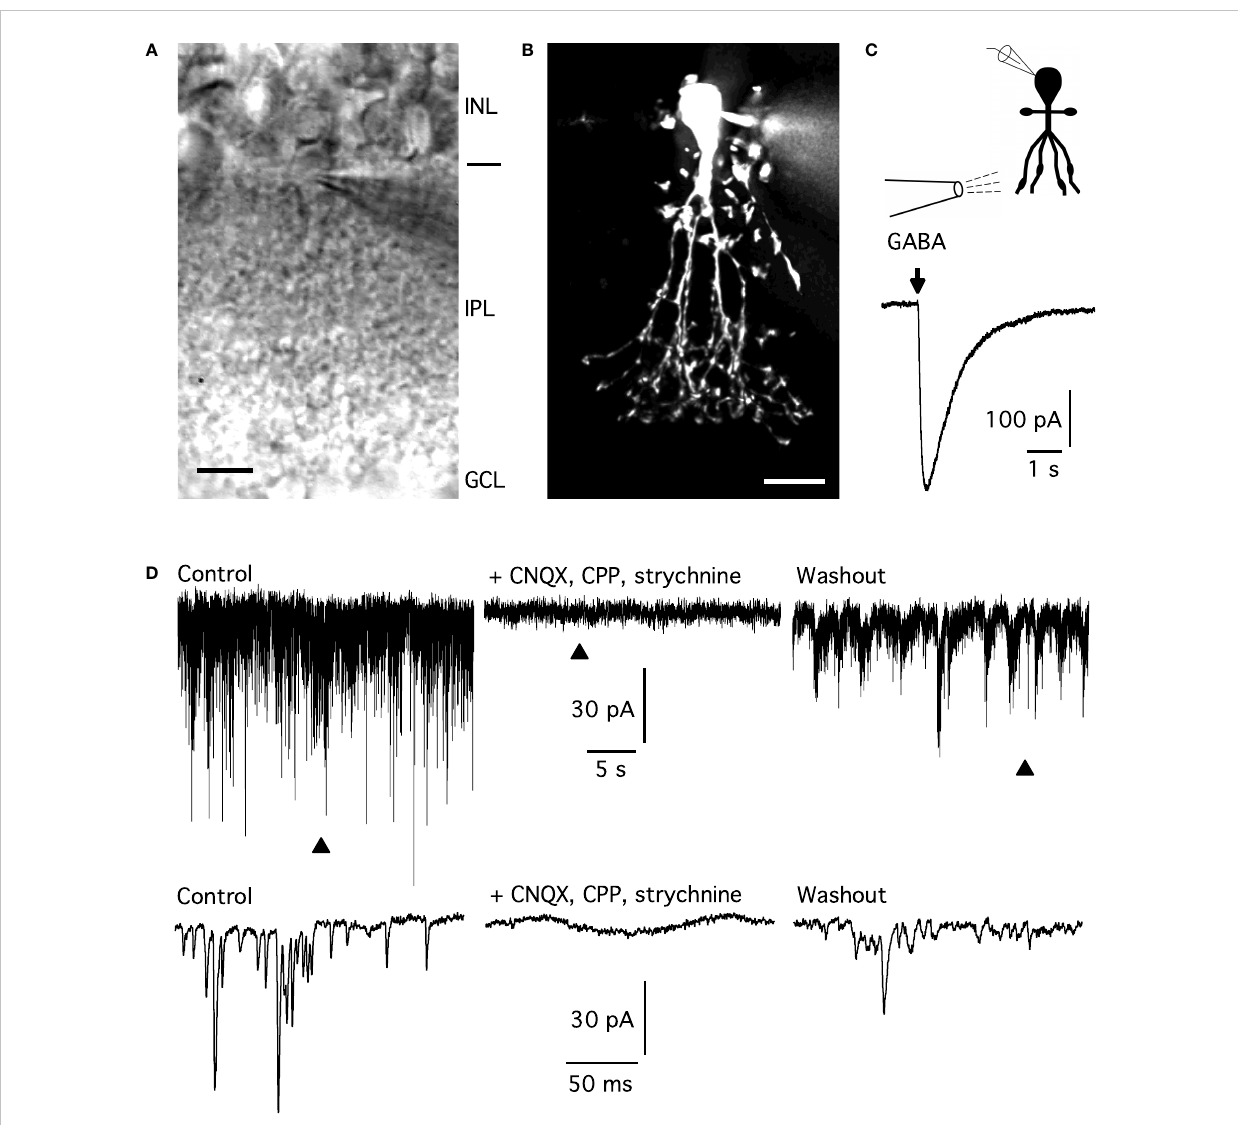
FIGURE 1 Identi fi cation of AII amacrines and lack of spontaneous GABA receptor-mediated synaptic currents. (A) Infrared differential interference contrast videomicrograph (IR-DIC) of a retinal slice with visible cell body and apical dendrite of an AII amacrine cell during whole-cell recording (note visible tip of patch pipette). Scale bar, 10 µm. Retinal layers indicated by abbreviations (INL, inner nuclear layer; IPL, inner plexiform layer; GCL, ganglion cell layer). (B) Maximum intensity projection of image stack of wide- fi eld fl uorescence image (after deconvolution) of AII amacrine in (A) fi lled with Alexa 594 via patch pipette. Scale bar, 10 µm. (C) Current evoked in an AII amacrine ( V hold = -60 mV) by application of GABA (1 mM, 100 ms) from a puffer pipette during whole-cell, voltage-clamp recording (the recording con fi guration is indicated by the schematic at top, with the tip of the puffer pipette located approximately over stratum 5 of the inner plexiform layer). The arrow indicates the onset of GABA application. The bath and puffer pipette solutions contained CNQX (10 µM) and strychnine (300 nM). Voltage-gated Na + channels were blocked by QX-314 in the intracellular solution. (D) Whole-cell, voltage-clamp recording from an AII amacrine ( V hold = -60 mV) in three different conditions (the intracellular solution contained QX-314). Left: control (no pharmacological blockers of synaptic receptors) with relatively high frequency of (inward) spontaneous postsynaptic currents (spPSCs). Middle: with CNQX (10 µM), CPP (20 µM), and strychnine (300 nM) in the bath solution, no spPSCs were observed. Right: after CNQX, CPP, and strychnine were washed out, the amplitude and frequency of spPSCs partially recovered. For each condition, current is displayed at both a slow (top) and a fast (bottom) time scale, triangles mark approximate location of epochs expanded at